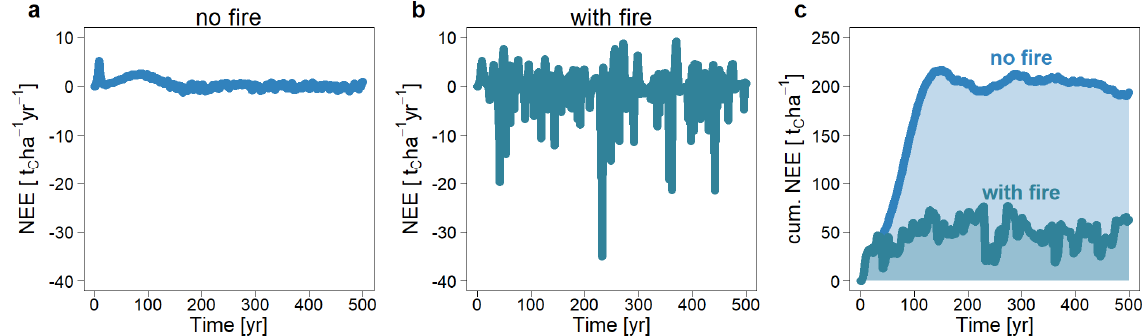
Figure 12. Simulated carbon balance (net ecosystem exchange) over time in a tropical forest without fires ( a ) and with recurrent fires on average every 4 years ( b ). Positive values correspond to carbon sink behavior. ( c ) Cumulative carbon balance of both scenarios.